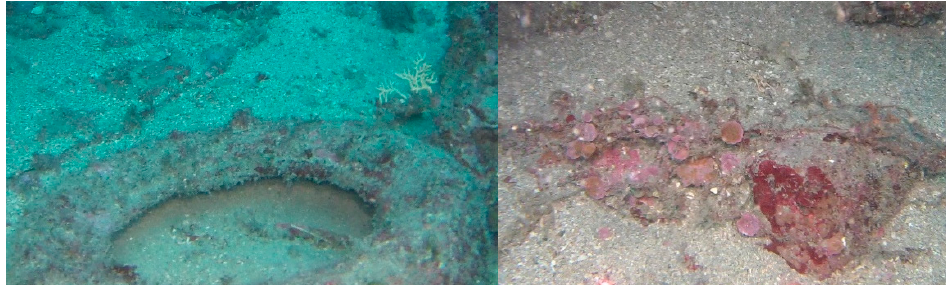
Figure 7. Two examples of obtained frames: on the left a found item belonging to the group “General waste” and on the right a found item belonging to the group “Fishing gear”.